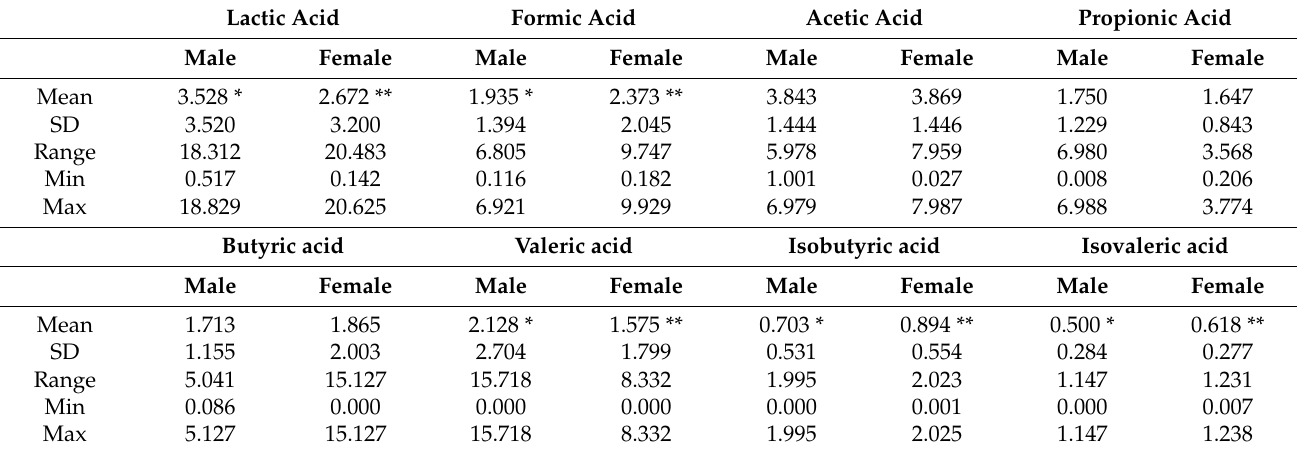
Table 3. Concentrations of lactic acid, SCFA and BCFA in the group of males and females. Lactic Acid Formic Acid Acetic Acid Propionic